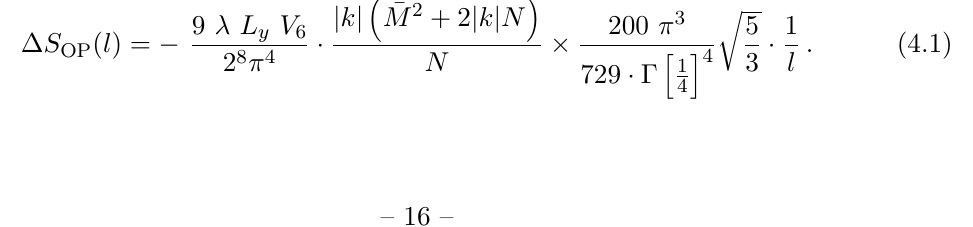
we find that this quantity vanishes, contrary 0 and hence creeping towards the confining 0 , the curve is overlapping with that of B conf 0 8